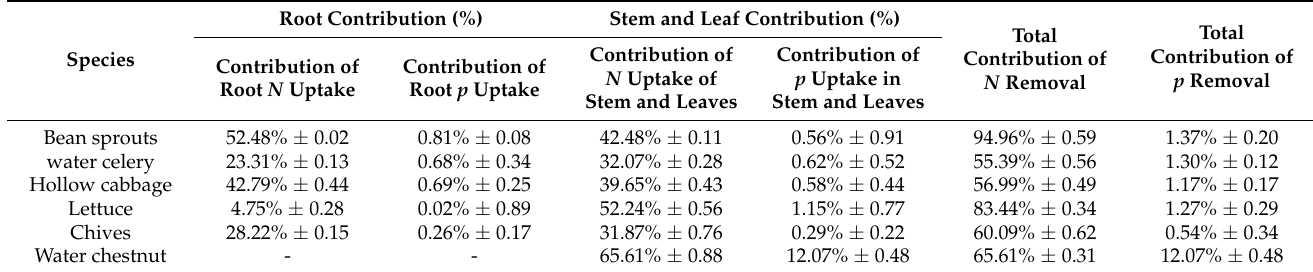
Table 2. Contributions of six plant species to nitrogen and phosphorus